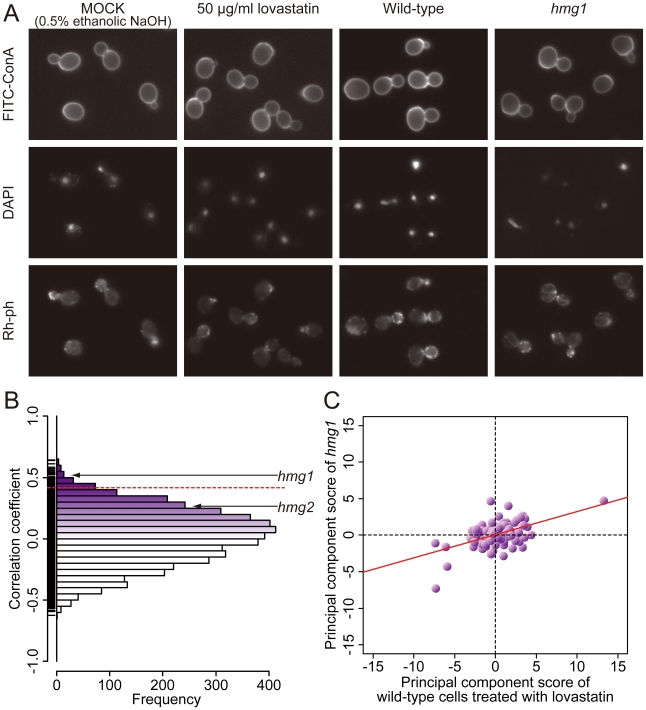
Lovastatin treatment and the results of target inference.A) Photographs of wild-type cells treated with 50 µg/ml lovastatin and the hmg1 mutant. Cells were triply stained with FITC-ConA, Rh-ph, and DAPI. Quantitative analysis of lovastatin-induced morphologic changes is summarized in Table S3. B) A histogram of correlation coefficients (R) between the mutant and lovastatin-treated wild-type cells. The dashed red line indicates the position of the R value corresponding to the two sided P value of 0.05 with the Bonferroni correction based on a correlation coefficient test. C) Two-dimensional plot of lovastatin-treated wild-type cells and the hmg1 mutant. Scores for the 104 principal components are plotted. The red line represents a linear regression model (R = 0.512).